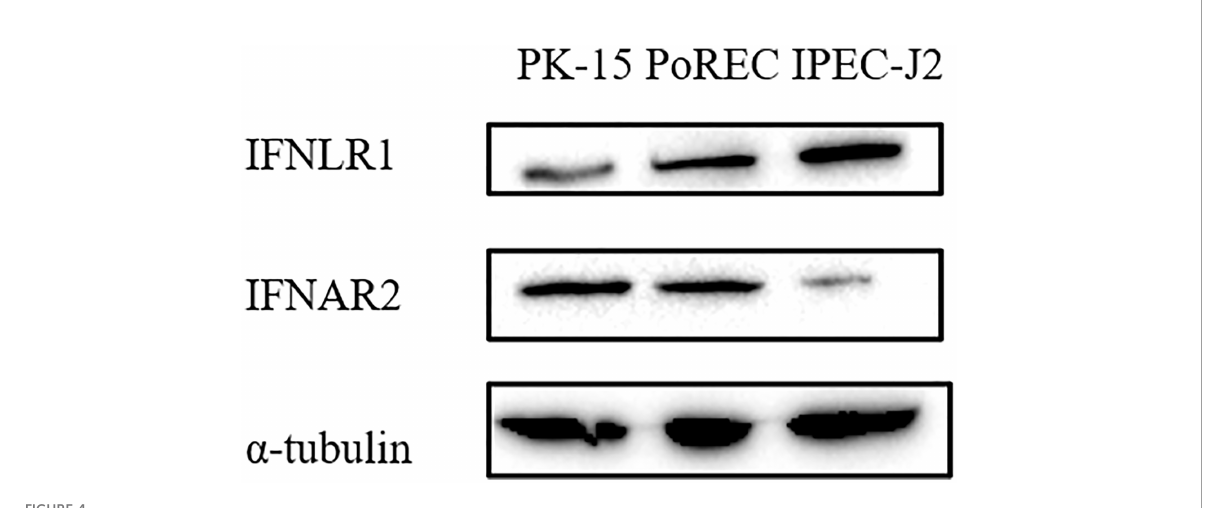
FIGURE 4 Different porcine epithelial cells show differences in protein expression levels of the type I IFN receptor chain IFNAR2 and type III IFN receptor chain IFNL1. PK-15, PoREC, IPEC-J2 cells were harvested and prepared for Western blot analysis using antibodies against IFNLR1, IFNAR2 and a